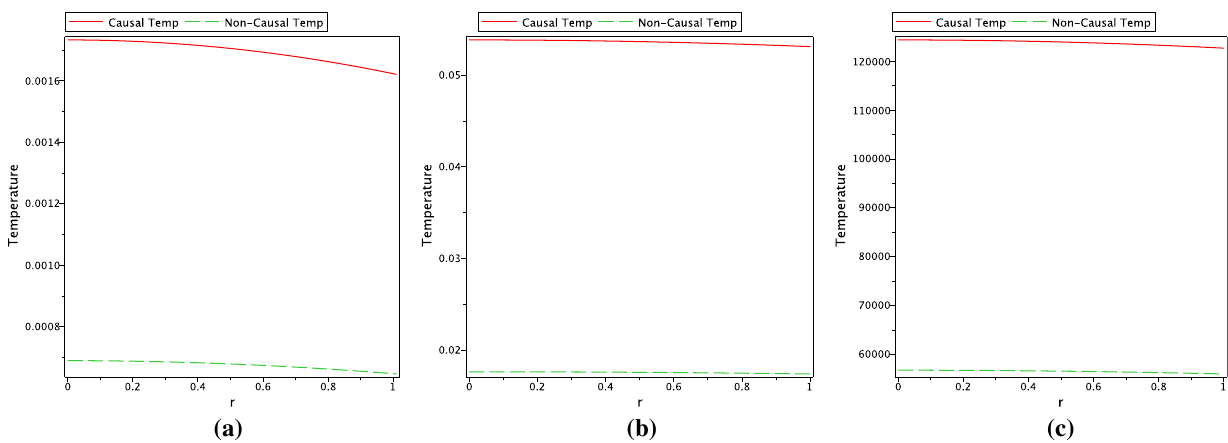
Fig. 12 a – c Shows the plots of the temperature profiles of the collapsing stellar system w.r.t. radial coordinate r for σ = 0 and for f ( R ) = R + λ R 2 with λ = 5, f ( R ) = R 1 + (cid:3) with (cid:3) = 0 . 01 and f ( R ) = R + λ